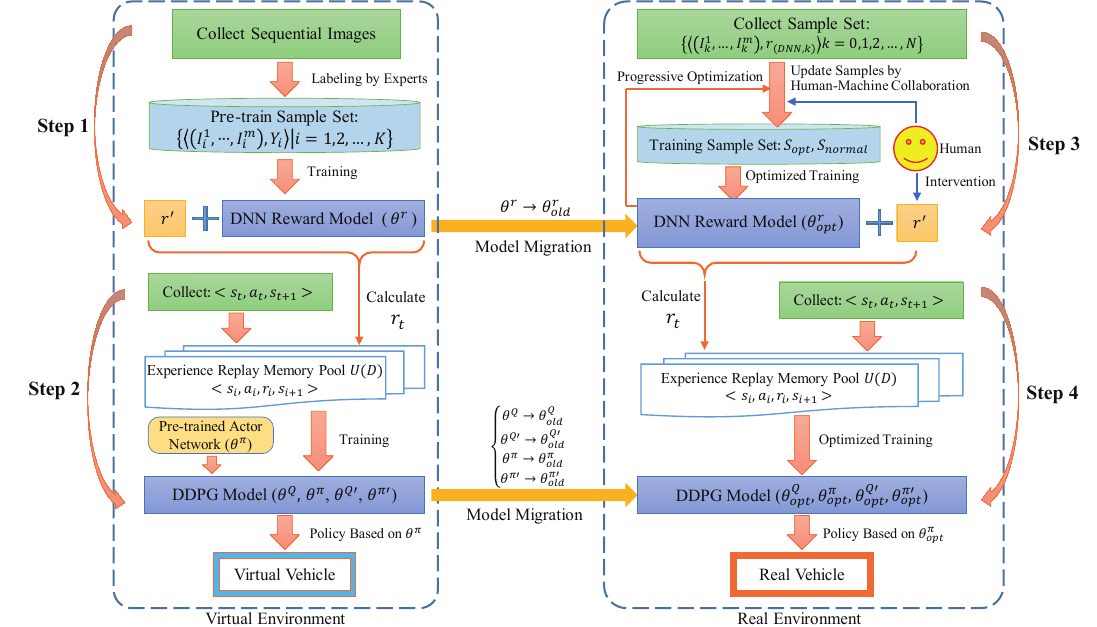
Figure 6. The training process of the autonomous driving behavior learning